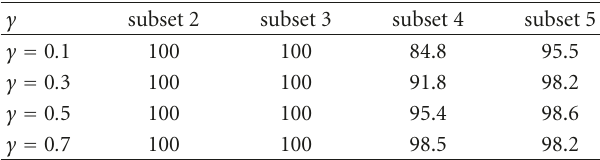
Table 4: Rank one recognition rates (in %) obtained with the CGFC approach on the EYB database for four di ff erent values of the fusion parameter γ